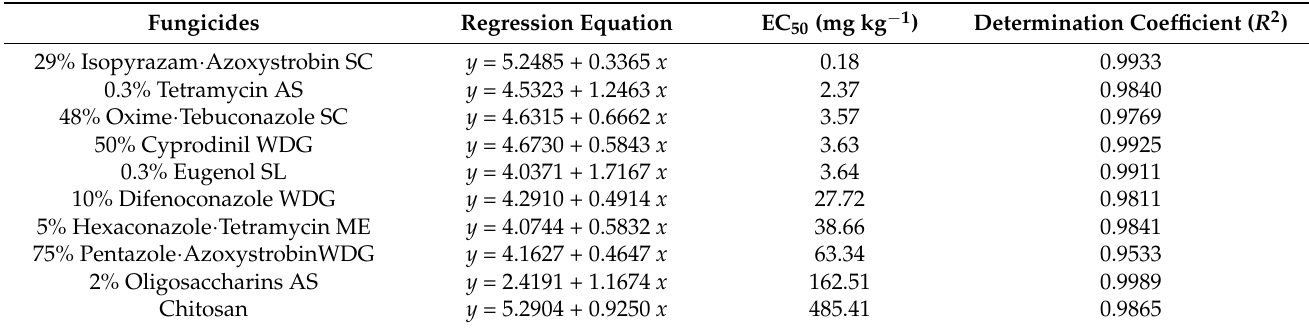
Table 1. The toxicity of ten fungicides against Lasiodiplodia theobromae .